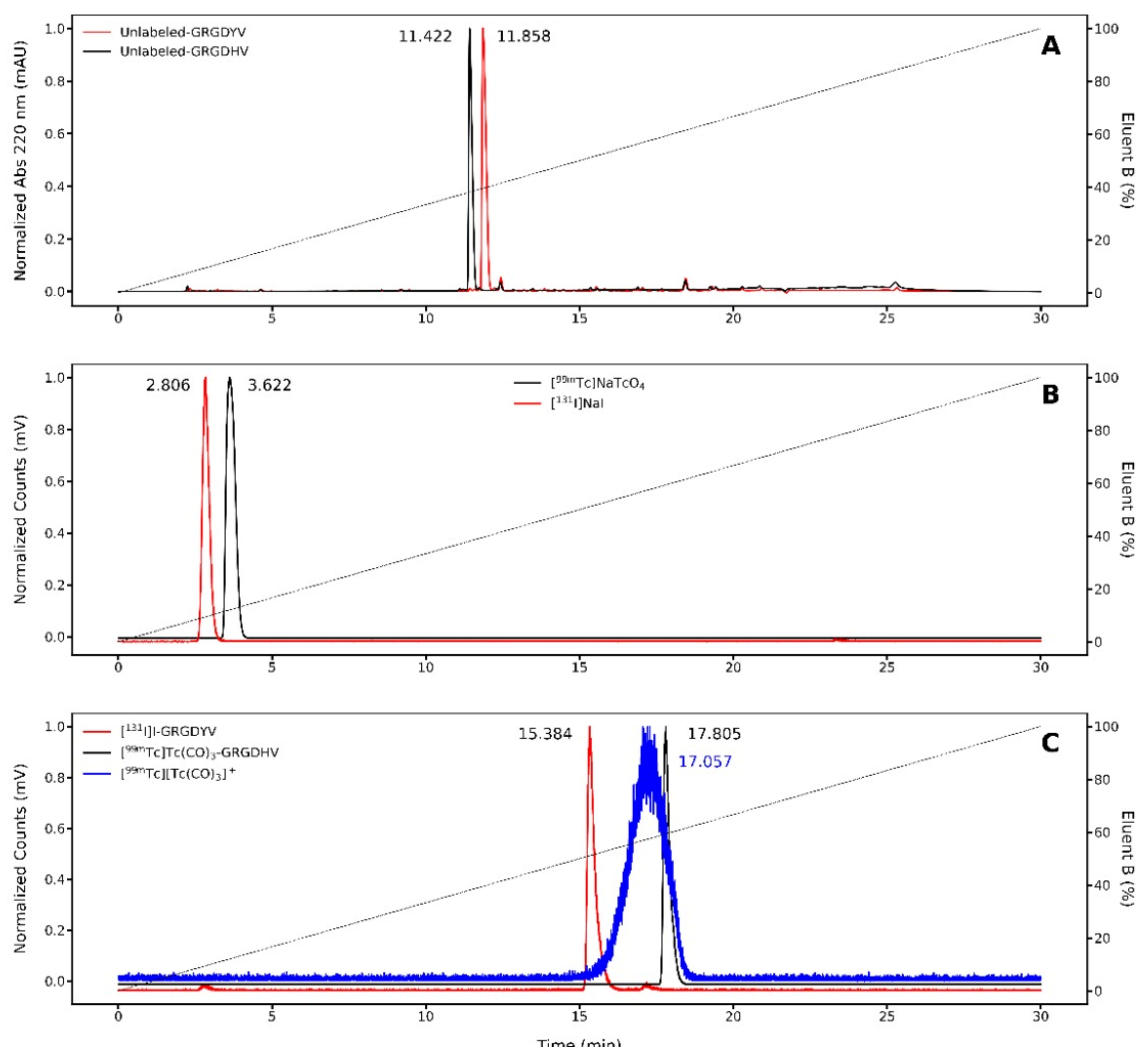
Figure 4. Radiochemical purity evaluated by Reversed Phase-High Performance Liquid Chromatography (RP-HPLC). Chromatograms of ( A ) non-labeled peptides; radiochromatograms of ( B ) [ 131 I]NaI, [ 99m Tc]NaTcO 4 , ( C ) radiopeptides and [ 99m Tc][Tc(H 2 O) 3 (CO) 3 ] + . Each peptide was separately injected.